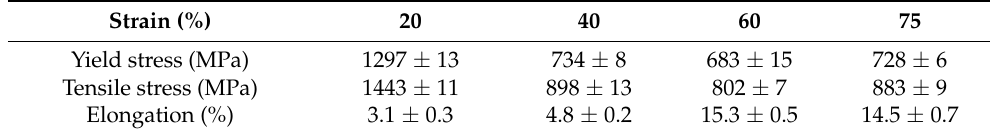
Table 2. Mechanical properties at different strains.